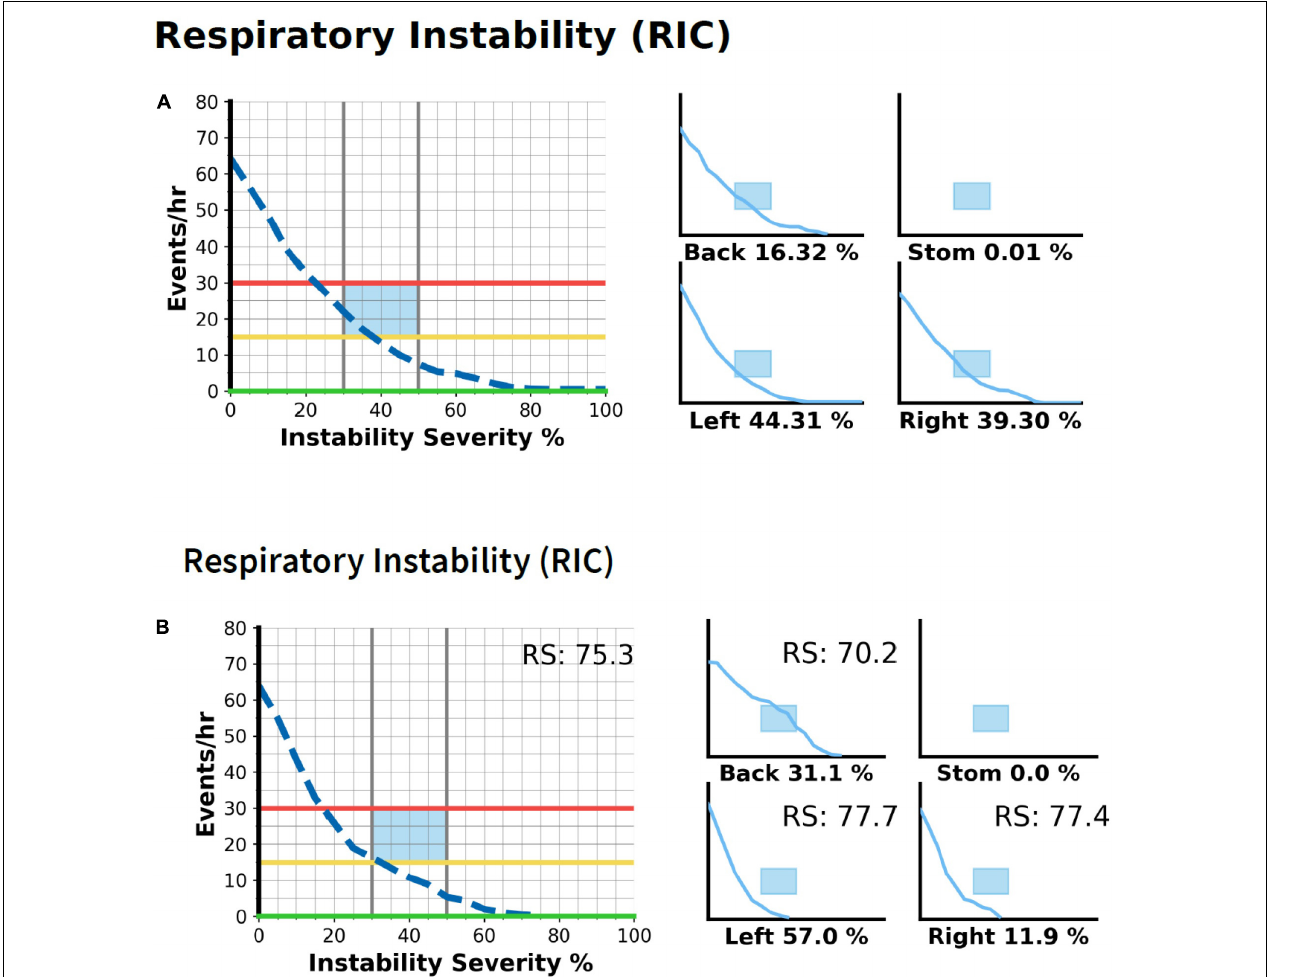
FIGURE 4 | The postural OSA is detected by comparing RICs in different body positions. On the left is the whole night RIC graph, on the right data are split by body position, with the percentage of time spent in every position reported. (A) The patient is classified as mild-to-moderate OSA and events occur irrespective of body position. (B) The patient would be classified as mild OSA considering the graph of the whole night, instead, he has severe sleep apnea in the supine position and almost no events in the lateral position. TABLE 1 | Anthropometric data and results of sleep studies in the different groups of patients (mean ± SD ). Normal Mild-to-moderate OSA Severe OSA Positional OSA Non-OSA disease 19 40